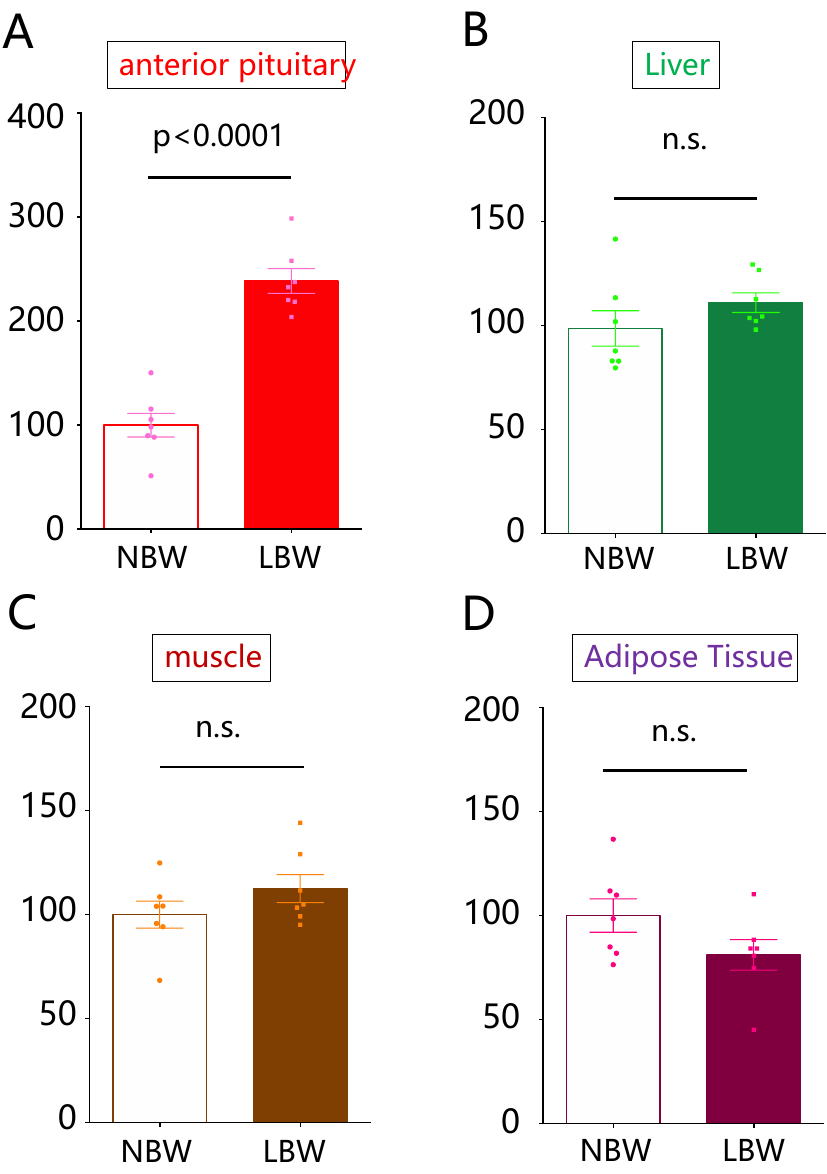
Figure 1. Expressions of Gas5 lncRNA in the pituitary, liver, skeletal muscle, and adipose tissues of Fig. 1 NBW and LBW rats. The expression levels of Gas5 lncRNA in the pituitary ( A ), liver ( B ), skeletal muscle ( C ), and adipose tissues ( D ) of control rats (NBW) and LBW rats were quantified. The mRNA expression level is a ratio obtained by correcting the ∆∆ CT values of Gas5 lncRNA with the ∆∆ CT values of GAPDH and setting the value of NBW to 100 ( n = 7). Statistical analysis was performed using unpaired t -tests. NBW, normal birthweight; LBW, low birthweight, n.s.; not